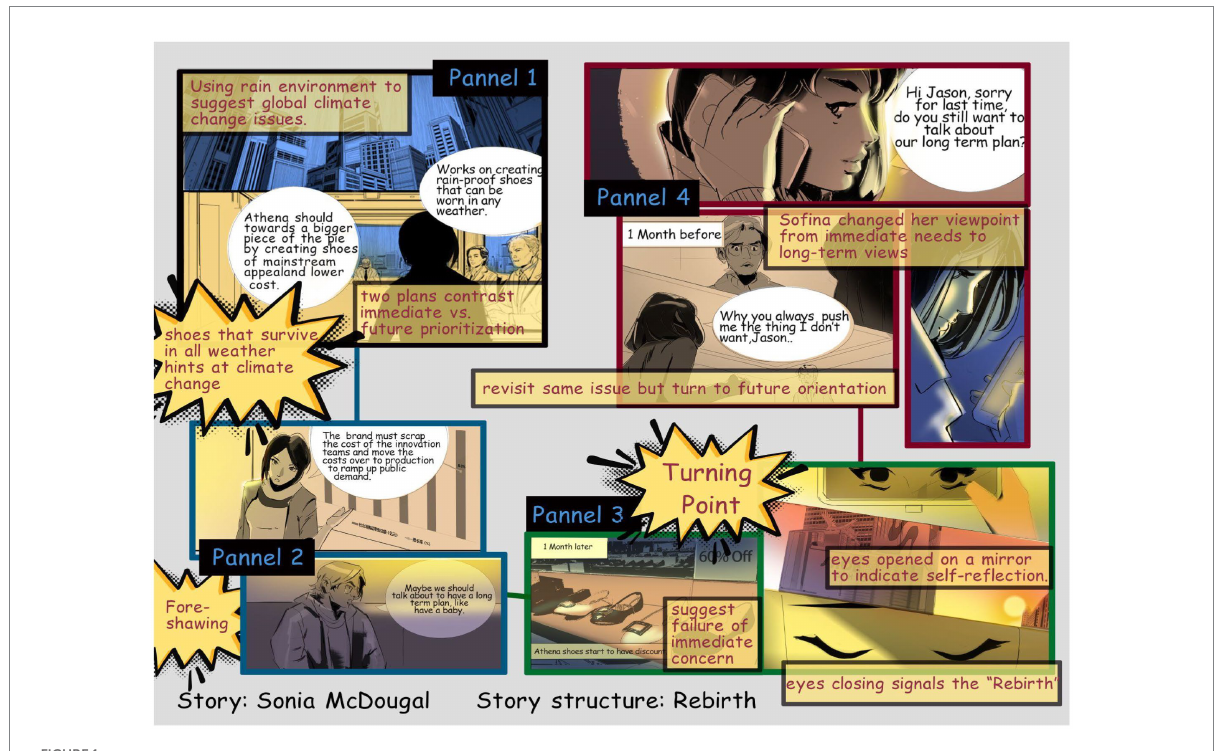
FIGURE 1 Persuasion through visual design in Sonia McDougal